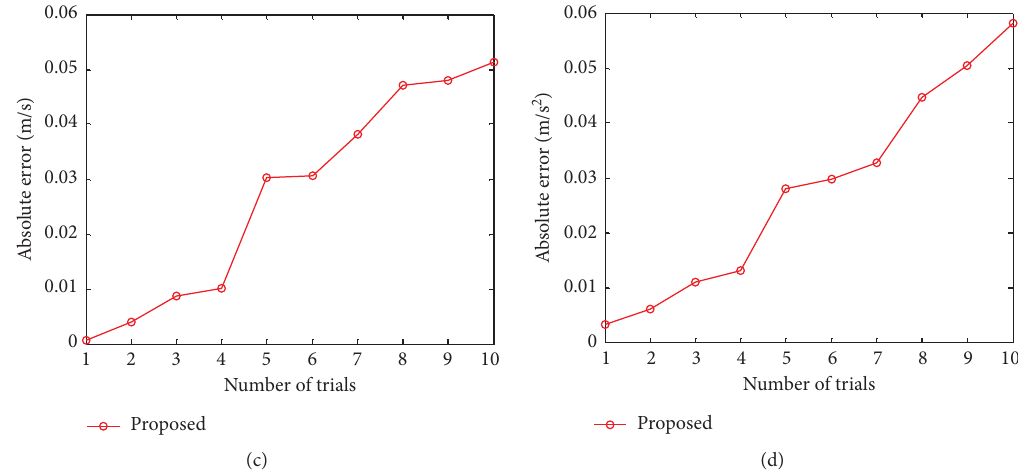
Figure 6: Estimation results as a function of range velocity varying from 1m/s to 10m/s at v the azimuth velocity estimation using the proposed method, (b) a comparison of the errors from the proposed method and contrast method, (c) absolute error in the range velocity estimation using the proposed method, and (d) absolute error in the range acceleration estimation using the proposed method.